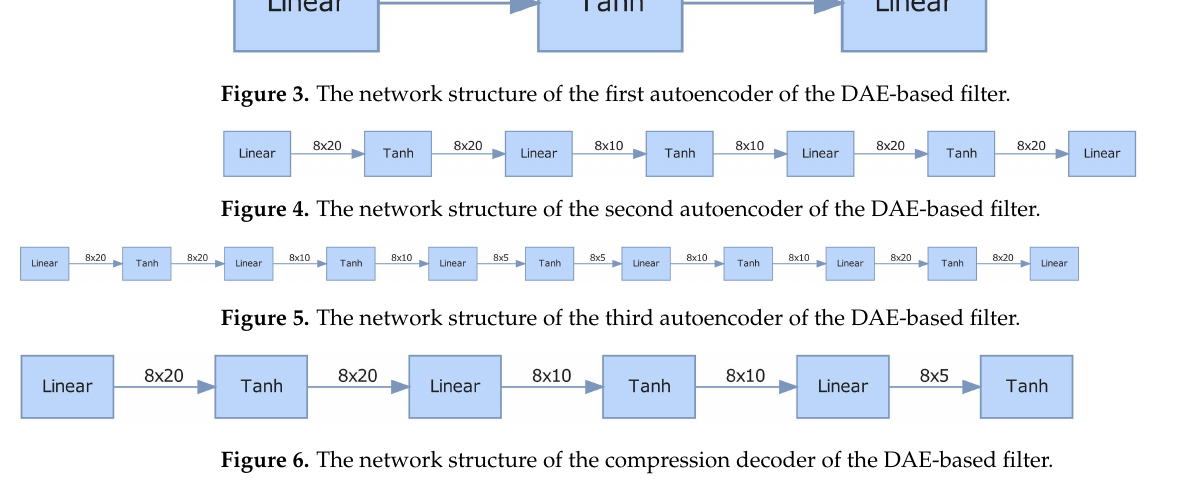
Figure 6. The network structure of the compression decoder of the DAE-based filter.